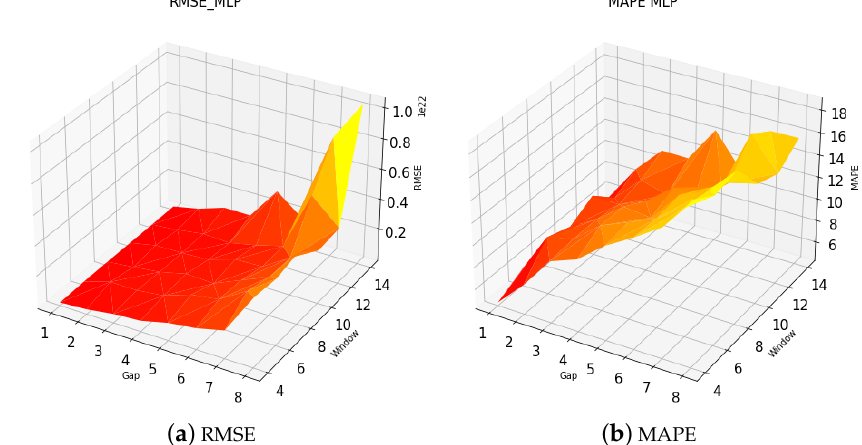
Figure 10. RMSE and MAPE for different windows (number of past samples) and gaps (number of years ahead) from the MLP model.